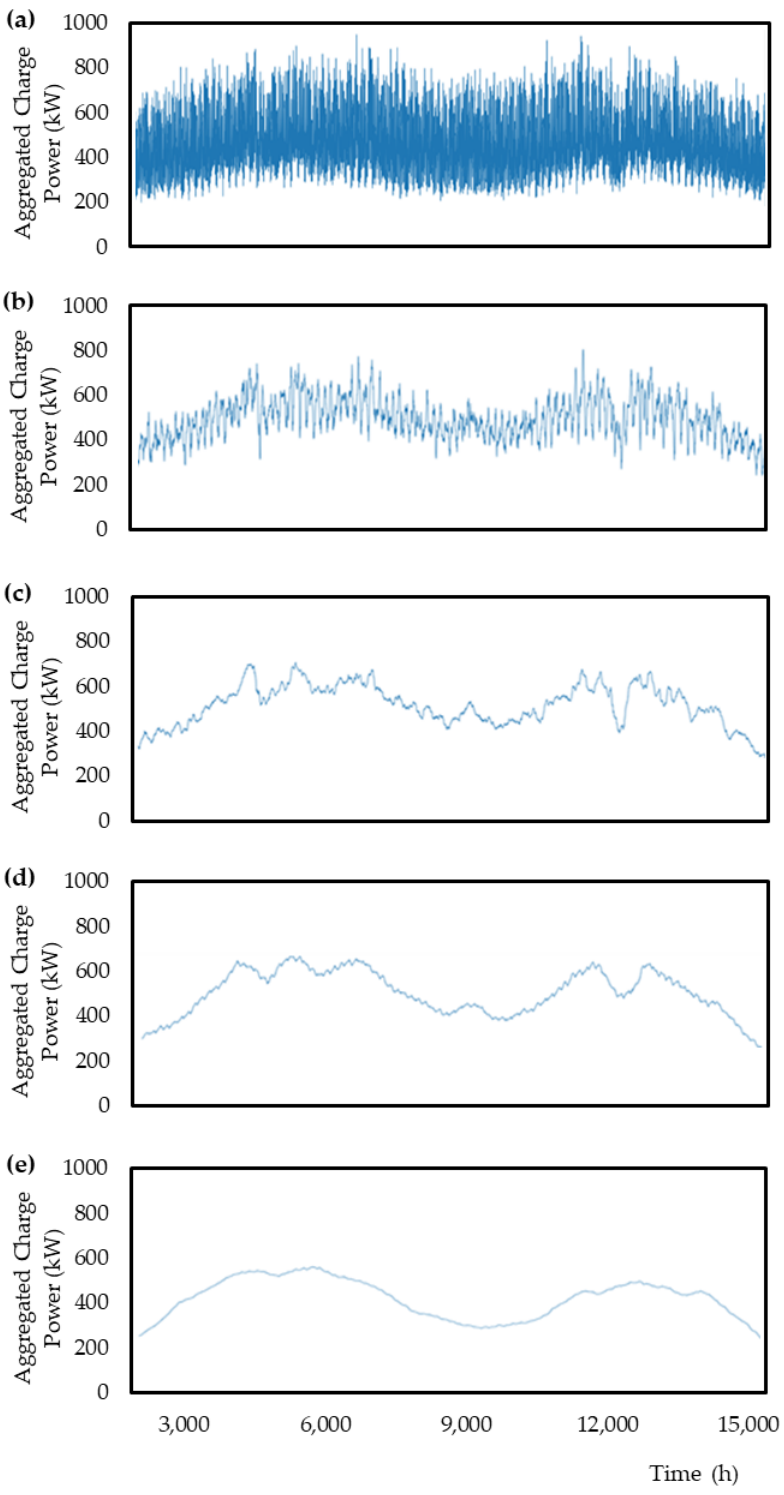
Figure 6. The original data sequence of the aggregated daily charging load ( a ) and the result of CEEMDAN; daily ( b ) weekly ( c ), monthly ( d ), seasonally ( e ).